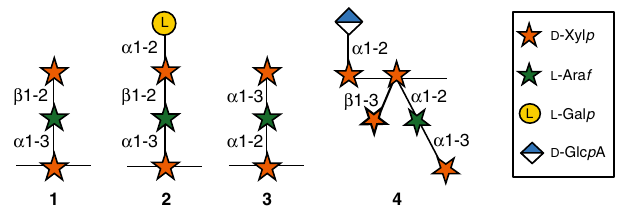
Fig. 1 Structures of the four major side chains of the GAX oligosaccharides in the Coculture Broths. Orange stars: D -Xylopyranose, green stars: L -Arabinofuranose, yellow circles: L -Galactopyranose, blue and white diamonds: D -glucuronic acid. The structures were determined using NMR spectroscopy and MALDI-TOF MS spectrometry. Details of the structural characterization are shown in Supplementary Figs. 1 and 3 and Supplementary Tables 1, 2, and 3.